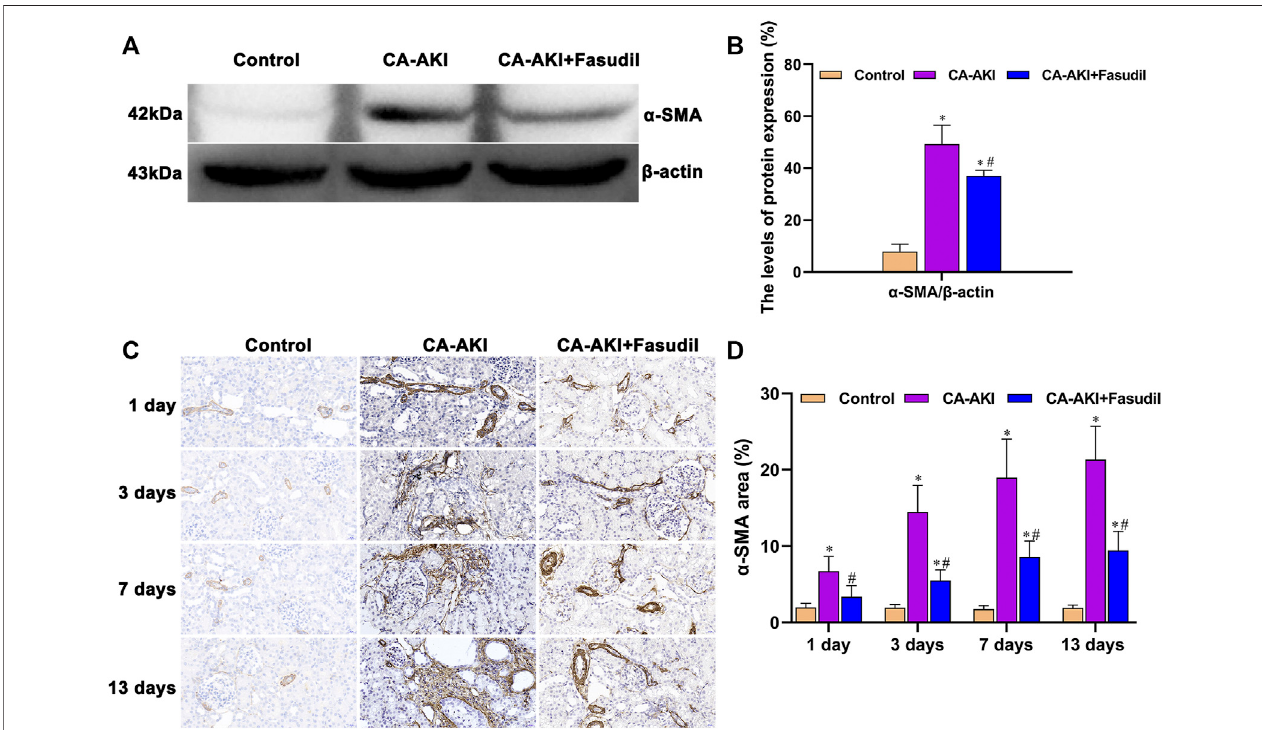
FIGURE 11 | α -SMA expression in three animal groups: (A) expression levels of α -SMA by group (western blot); (B) relative densitometry analysis of protein ratios; (C) α -SMA expression by group; and (D) α -SMA scores by group. * p < 0.05 between CA-AKI/CA-AKI + Fasudil and controls; # p < 0.05 between CA-AKI + Fasudil and CA-AKI.